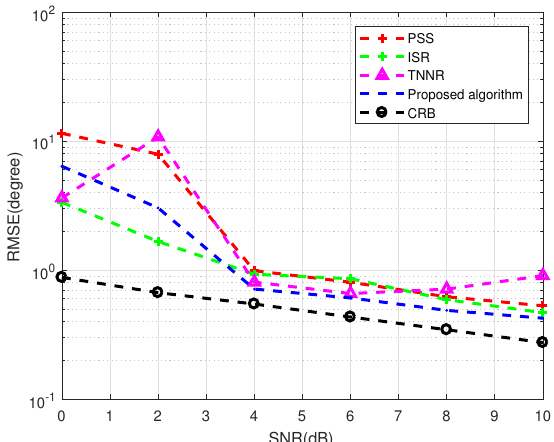
Figure 6. RMSE versus the SNR for two uncorrelated